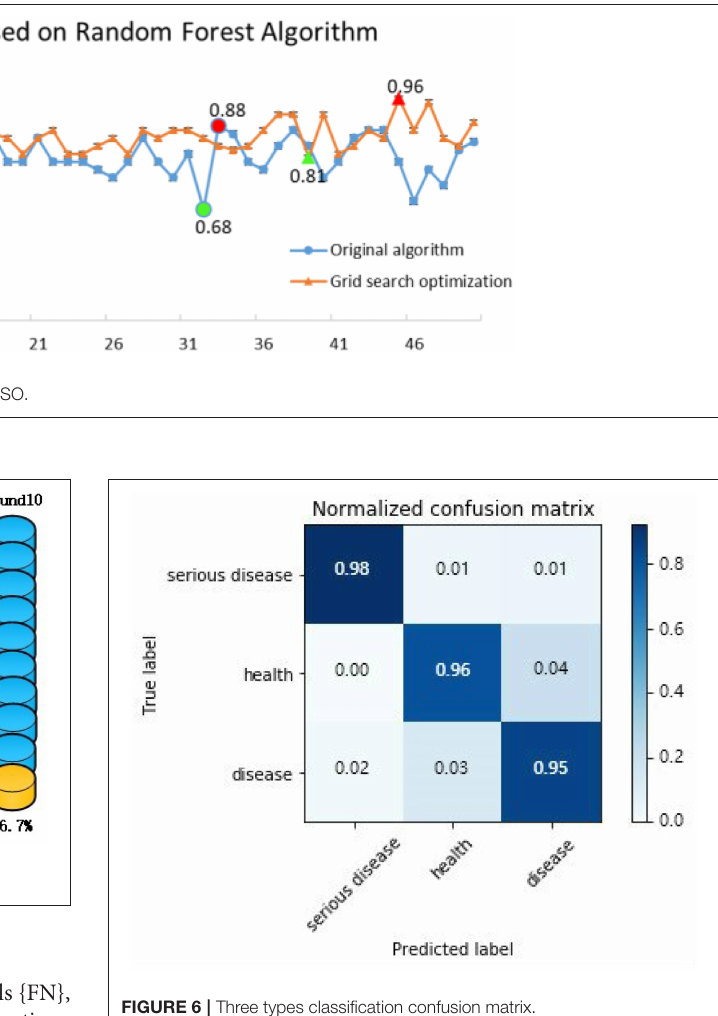
FIGURE 6 | Three types classification confusion